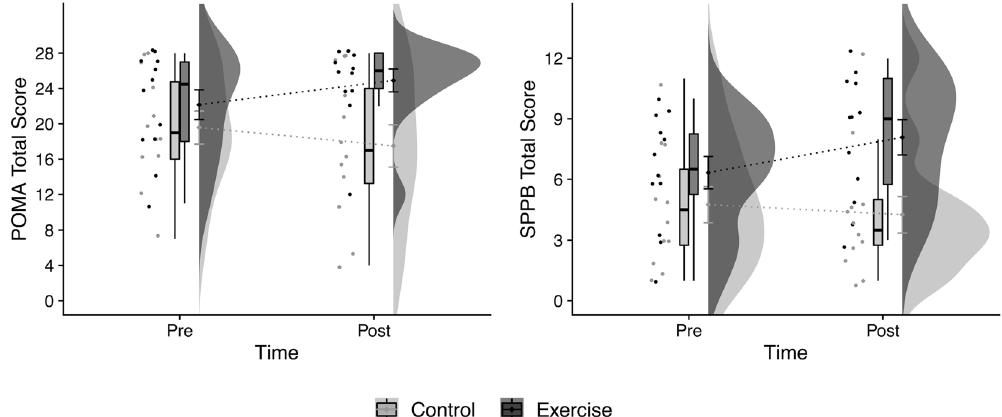
Figure 1. Raincloud plot 46 of the changes in the Performance-Oriented Mobility Assessment total score (POMA-T) and the Short Physical Performance Battery total score (SPPB-T) in the exercise (n = 12) and control groups (n = 12). Points are raw data obtained for each participant at each moment of measurement. Box plots represent the median (i.e., the line near the middle of the box) and interquartile range (IQR, lower quartile = 25th percentile and upper quartile = 75th percentile). The whiskers on either side of the IQR represent the lowest and highest quartiles of the data. The ends of the whiskers represent the maximum and minimum data values, and the individual dots beyond the whiskers represent outliers in the data set. Clouds represent probability density, and point and error bars in the base of the clouds are the mean ± SD. The dotted line represents the direction of the pre- and postintervention change in the two group